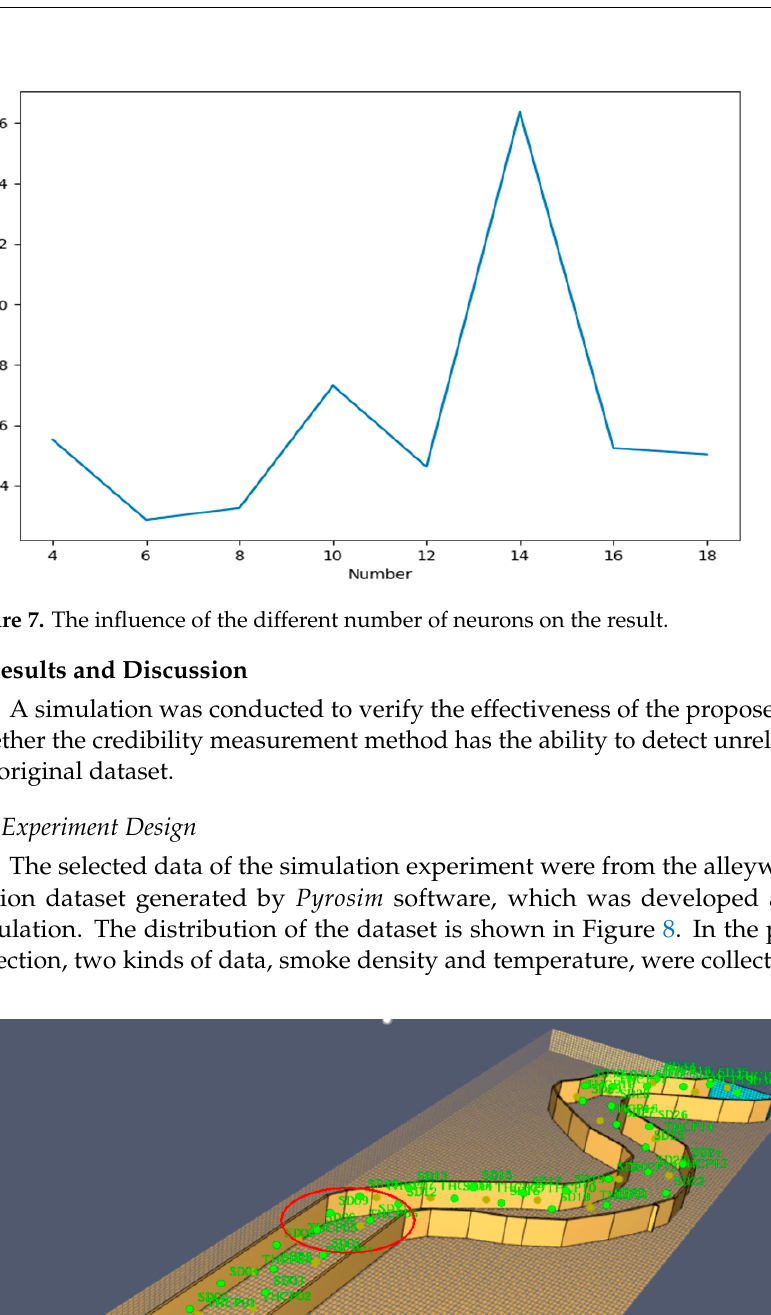
Figure 7. The influence of the different number of neurons on the result.